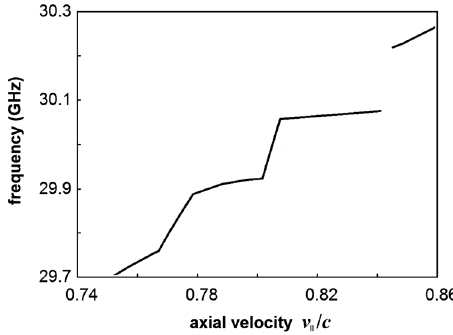
FIG. 4. Dependence of the oscillation frequency on the axial velocity of electrons v ∥ =c in the coaxial BWO with a 2D Bragg synchronizer